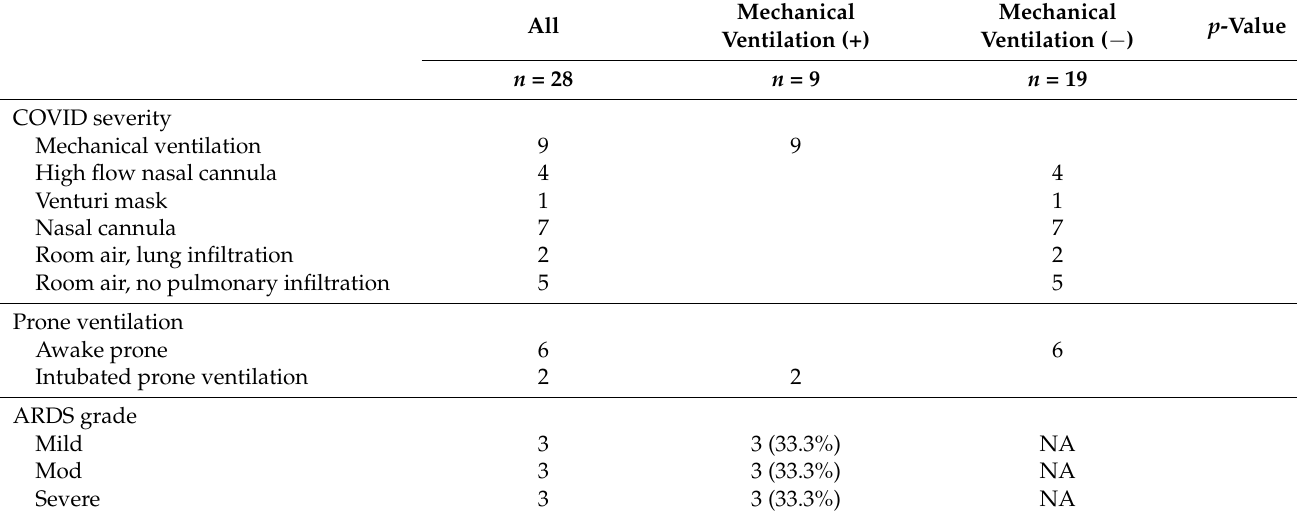
Table 1. Characteristics of 28 patients with COVID-19 infection between May 2021 and June 2021 at TCVGH categorized by the requirement of mechanical